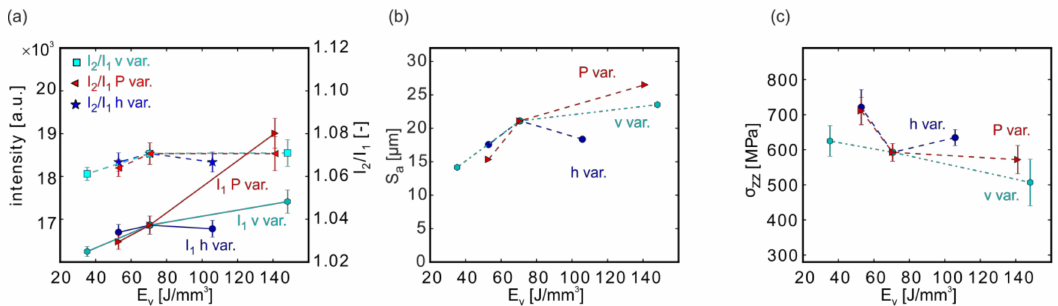
Figure 13. Comparison of the results for the variation of the hatch distance h, laser power P, and scanning velocity v in relation to E V (details see Section 3.4) on the MPM data ( a ), on the surface roughness ( b ), and on the residual stresses ( c